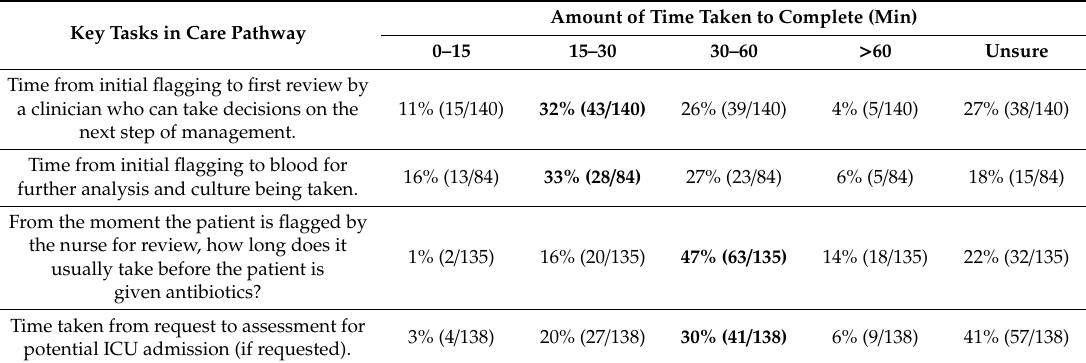
Table 2. Estimation of time taken to complete key tasks in the care pathway of patients with sepsis. The option that has been selected more often by the respondents is highlighted in